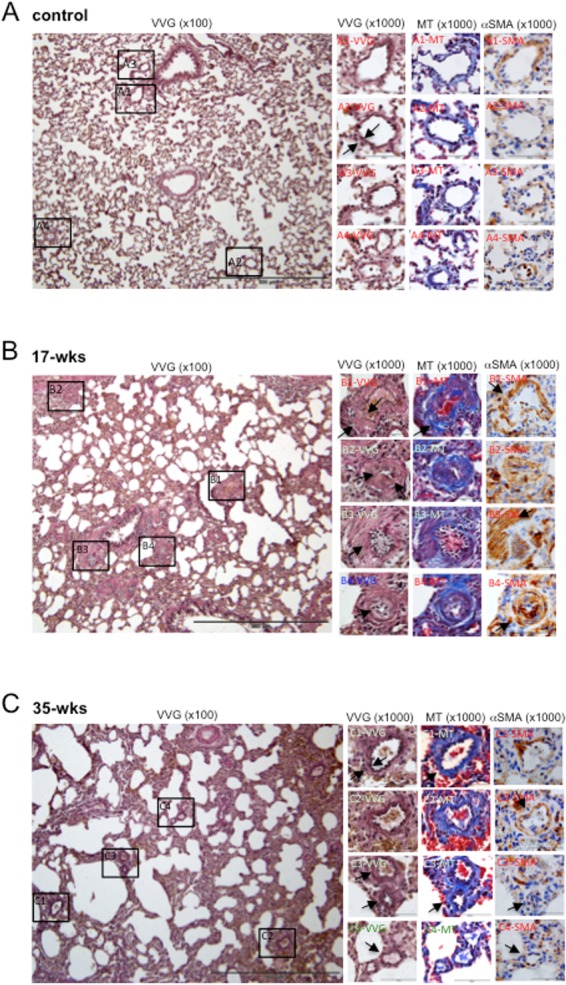
Lung structure.SU5416-injected rats were subjected to 3 weeks in hypoxia and then maintained in normoxia for 14 or 32 weeks (17- and 35-wks time points, respectively). The large panels on the left are representative VVG stains at x100 magnification. Sections of different sizes of pulmonary arteries (50-150nm) are enlarged (x1000) on the right, showing VVG stain, Masson’s trichrome (MT) stain and immunohistochemistry of α-smooth muscle actin (αSMA).